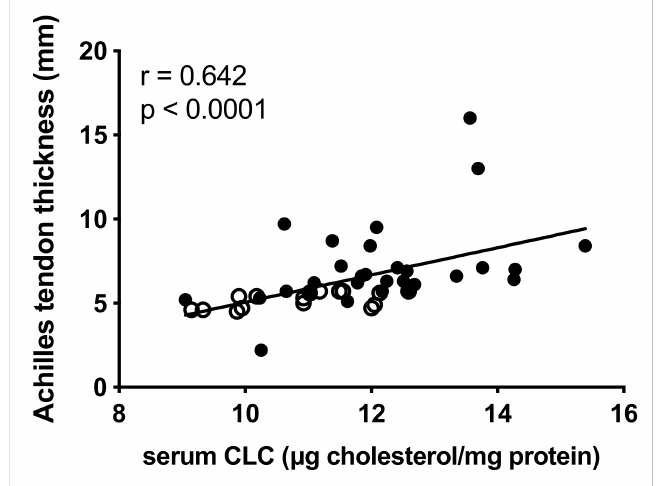
Figure 4. Correlation between serum cholesterol loading capacity (CLC) and Achilles tendon thick- ness in FH subjects. Spearman correlation coefficient was